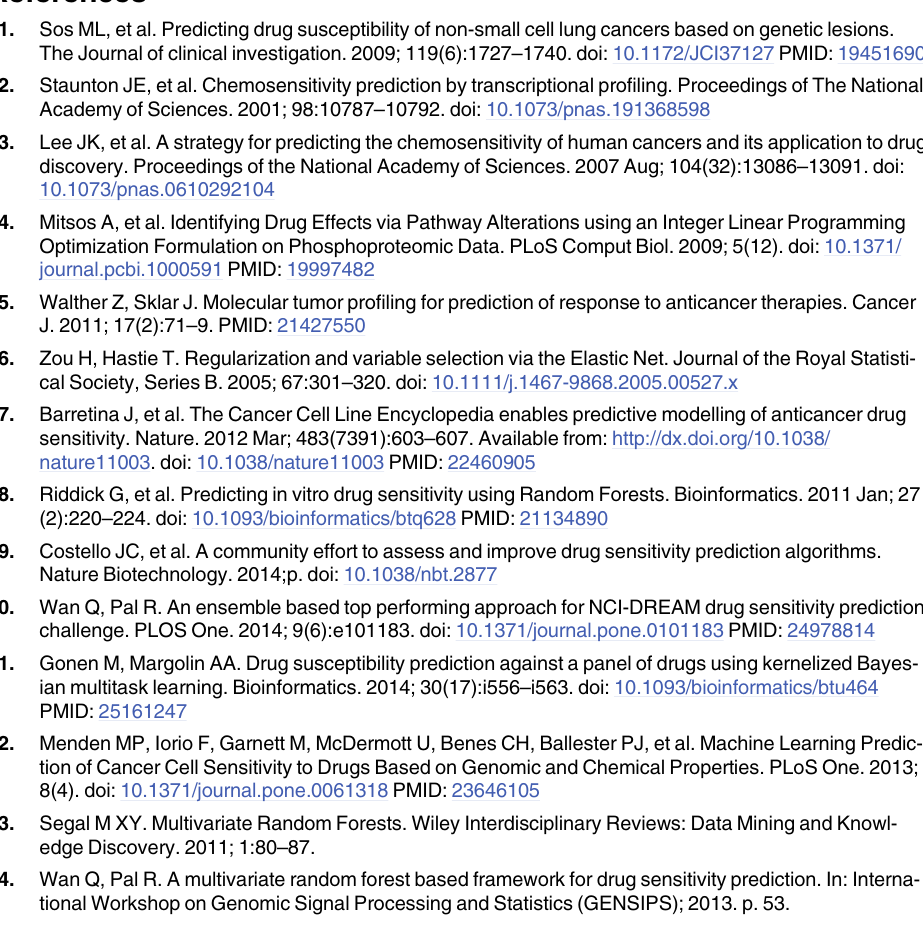
( Table F ). Results for CCLE Dataset drug sensitivity prediction for the combined set of 24 drugs in the form of Normalized Root Mean Square Error ( Table G ). Comparison of α for different sets of synthetic data with and without noise added to the drug response ( Table H ). Comparison of α for different amount of random subset of the original samples in a specific synthetic data. Original number of samples were 350 in this specific example ( Table I ). Simulation time for different drug- sets in GDSC data. The reported simulation times are the time needed to generate complete result for all drugs in a drug set for 5 fold cross validation ( Table J ). Simulation time for different drug- sets in GDSC data. The reported simulation times are the time needed to generate complete result for all drugs in a drug set for 30 – 70 case ( Table K ). Simulation time for different methods for all drugs of GDSC dataset (140) and CCLE dataset (24). The reported simulation times are the time (in seconds) needed to generate complete result for all drugs for 30 – 70 case ( Table L